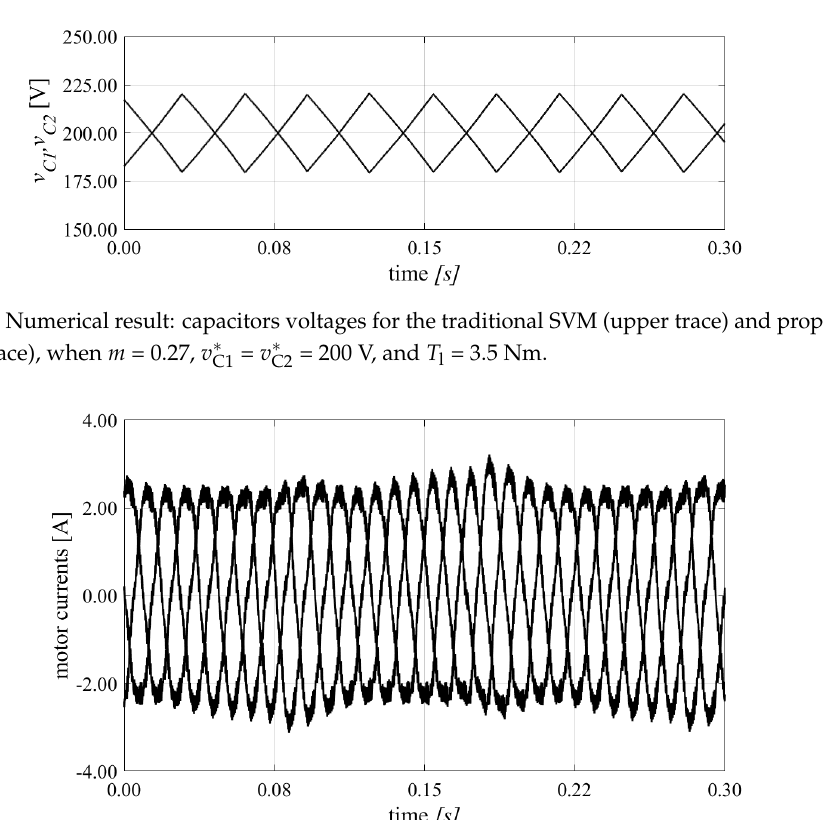
Figure 7. Numerical result: motor currents achieved with the traditional SVM, when m = 0.94, v ∗ = v ∗ = 200 V, and T l = 3.5 Nm. C1 C2